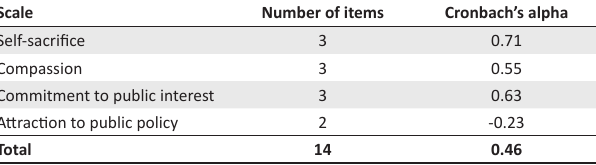
TABLE 4: Reliability statistics of the Public Sector Motivation scale.